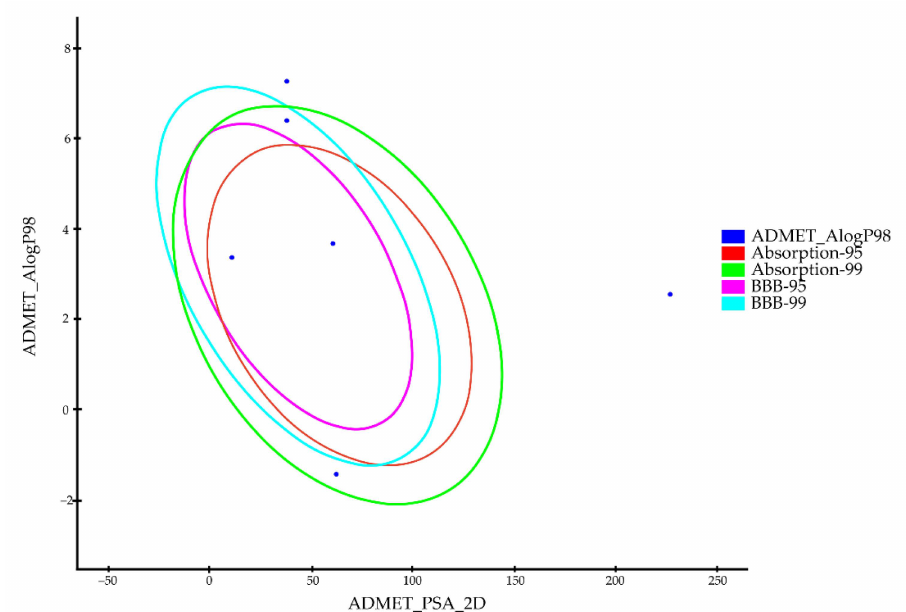
Figure 6. The plot of the two-dimensional polar surface area (PSA_2D) vs. the calculated ALogP98 for tested compounds showing the 95% and 99% confidence ellipses corresponding to the blood–brain barrier (BBB) and the human intestinal absorption (HIA) models.